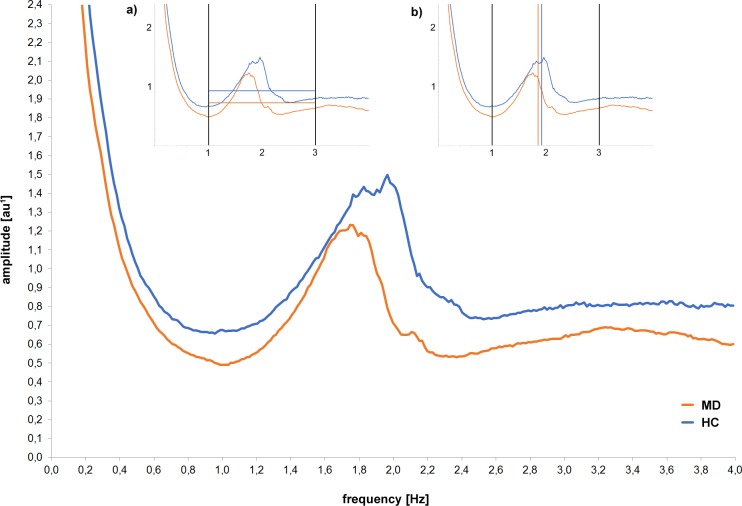
Spectral analysis of acceleration (frequency and amplitude) of MD patients at the beginning of treatment (MD) and healthy controls (HC) captured with the vertical axes of the chest-accelerometer.Mean amplitude values (in au1; grey and black horizontal resp.) as well as the group centroid frequency (in Hz; grey and black vertical line resp.) for the whole spectrum of walking (1–3Hz) are depicted in Fig 1a, 1b, respectively. 1arbitrary unit: values are based on g but attenuated due to the computation of the spectrum and the nonstationarity of the data.